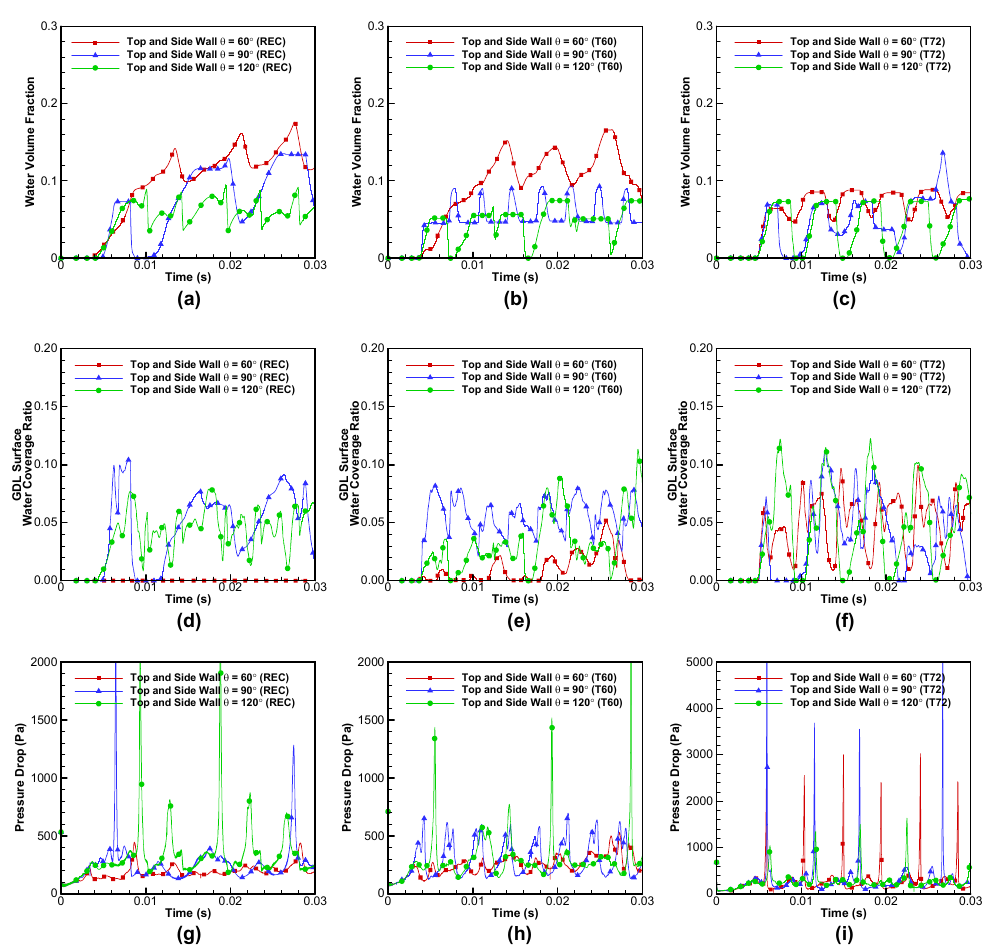
Figure 4. Effect of the top and side wall contact angle on the time evolution of ( a ) WVF (REC); ( b ) WVF (T60); ( c ) WVF (T72); ( d ) GWCR (REC); ( e ) GWCR (T60); ( f ) GWCR (T72); ( g ) pressure drop (REC); ( h ) pressure drop (T60); ( i ) pressure drop (T72) ( V in , air = 5.0 m · s − 1 , V in , water = 0.1 m · s − 1 , θ g = 130 ◦ , H12 water inlet